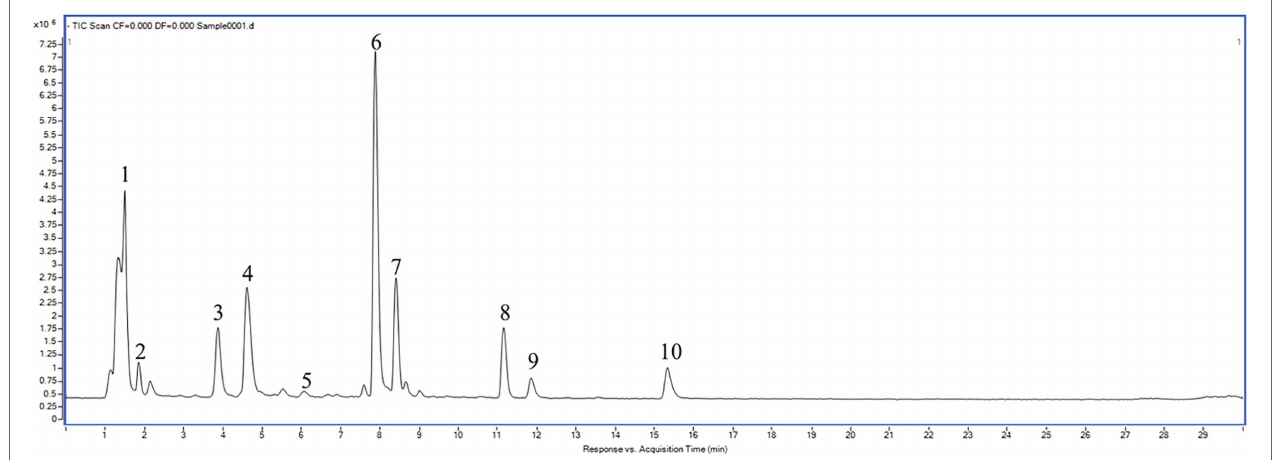
FIGURE 3 | HPLC-DAD-MS chromatogram of kiwi berry phenolic compounds. Peaks: 1, Protocatechuic acid ([M − H] − , m/z 153.2; MS/MS, m/z 109.8); 2, Proanthocyanidin B2 ([M − H] − , m/z 577.2; MS/MS, m/z 289.1); 3 (+)-gallocatechin ([M − H] − , m/z 305.1; MS/MS, m/z 248.1); 4, Quinic acid ([M − H] − , m/z 191.1; MS/ MS, m/z 146.9); 5, Proanthocyanidin C1 ([M − H] − , m/z 865.2; MS/MS, m/z 577.2); 6, Caffeic acid ([M − H] − , m/z 179.1; MS/MS, m/z 135.1); 7, Chlorogenic acid ([M − H] − , m/z 353.1; MS/MS, m/z 191.1); 8, Quercetin-3-O-galactoside ([M − H] − , m/z 463.1; MS/MS, m/z 300.0); 9, Quercetin-3-O-glucoside ([M − H] − , m/z 463.1; MS/MS, m/z 301.1); 10, Quercetin-3-O-rutinoside ([M − H] − , m/z 609.2; MS/MS, m/z